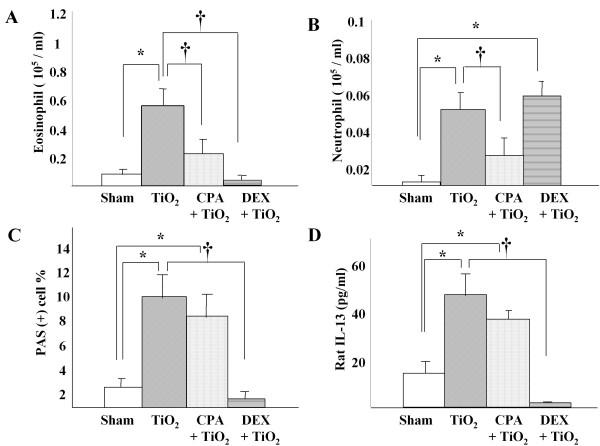
The cell distribution in BAL fluid of TiO2 instilled rats with or without pretreatment. Rats were pretreated with CPA (n = 6) or DEX (n = 6) and then treated intratracheally with TiO2. Saline (n = 8) or TiO2 (n = 8) was treated without pretreatment. At 48 h post-treatment, BAL fluids were collected and analyzed for the numbers of eosinophils (A), neutrophils(B), and the levels of IL-13(D). PAS (+) cells (C) were measured in the trachea as described in Methods. * p < 0.05 as compared with saline – treated group, † p < 0.05 as compared with TiO2 – treated group.